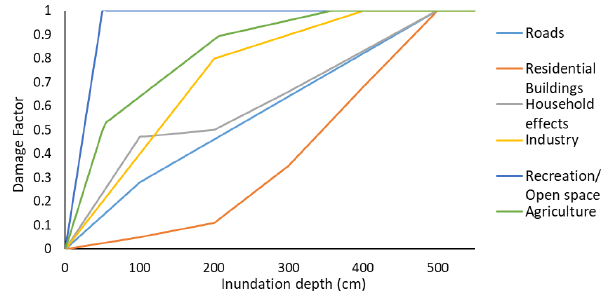
Figure 2. The flood damage curves depicting the relationship be- tween the inundation depth (cm) and the damage factor (Van- neuville et al.,